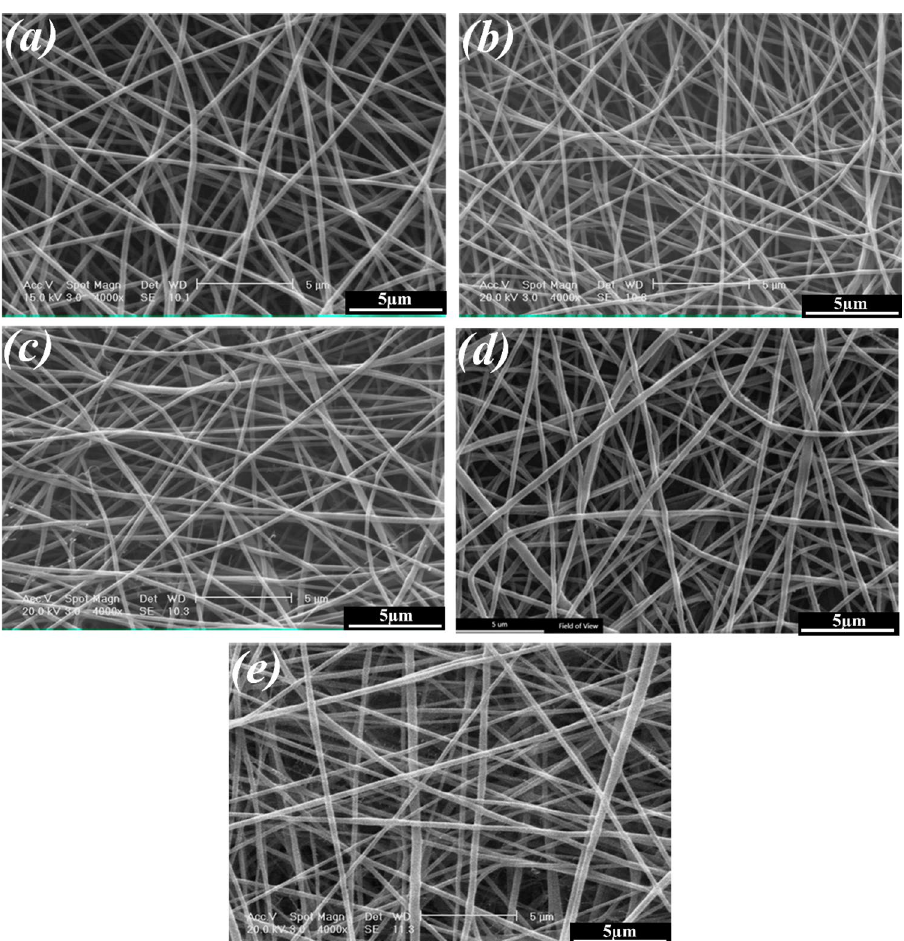
Figure 5. SEM images of the electrospun scaffolds: ( a ) PCL, ( b ) PCL-10HAMP, ( c ) PCL-20HAMP, ( d ) PCL- 30HAMP, and ( e )